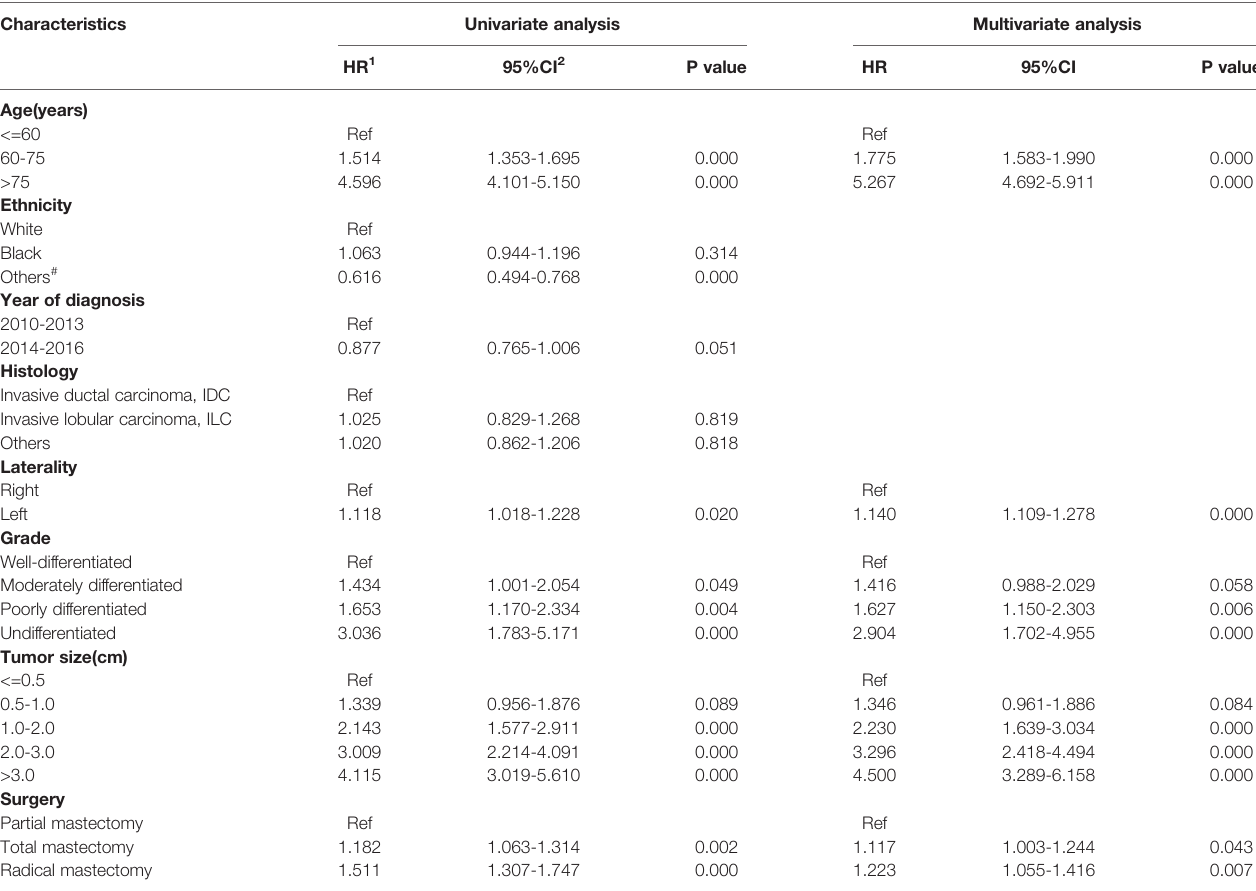
TABLE 2 | Univariate and multivariate analysis for the prognostic characteristics of OS.